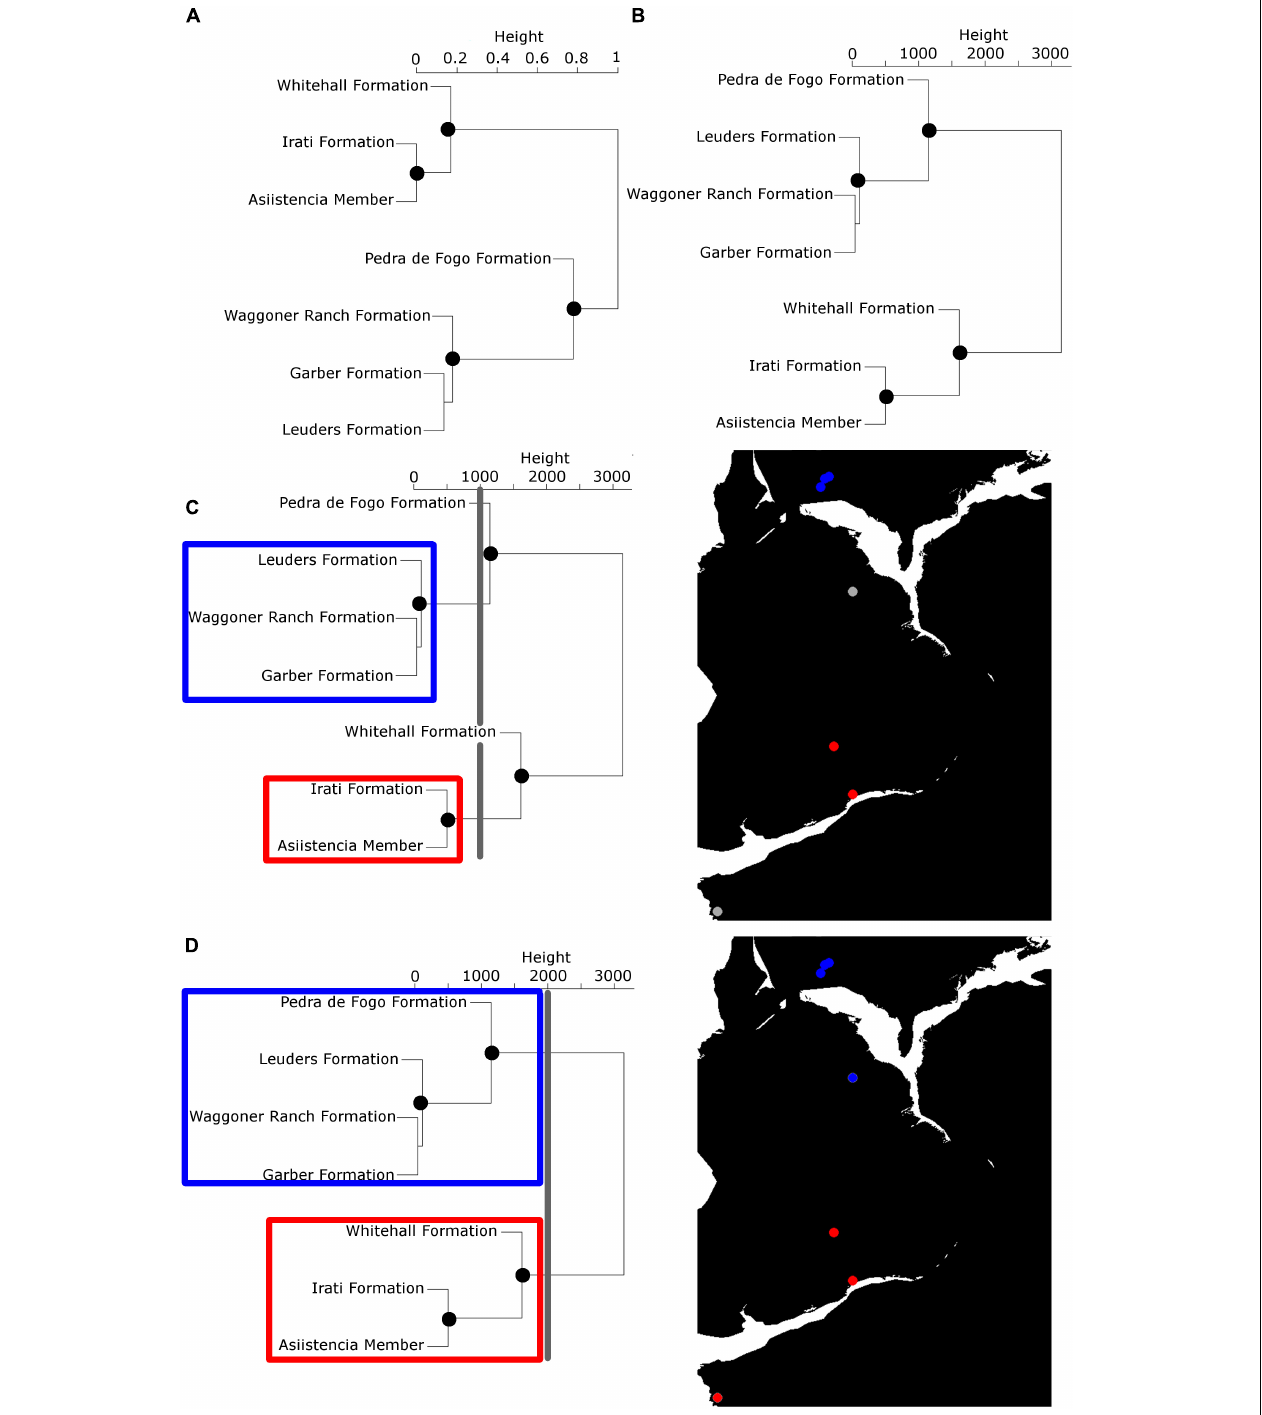
FIGURE 1 | An illustration of the method used to define bioregions, using the early Kungurian tetrapod record as an example time bin. (A) UPGMA (“average”) Cluster dendrogram of formations based on taxonomic (Forbes ∗ ) distances (Alroy, 2015); (B) Cluster dendrogram of formations based on Euclidean geographic distances. Nodes illustrated with black dots in A and B are shared between the two and represent continuous geographic areas of endemicity (bioregions). (C,D) An illustration of how the spatial scale at which the bioregions are defined is controlled. (C) A geographic cluster node height of 1000 km is used, so all formations within 1000 km of each other are united in their bioregions. Four bioregions are defined: those in blue (palaeoequatorial North America), those in red (palaeotemperature South America), and two individual formations colored in gray on the map. (D) A geographic cluster node height of 2000 km is used. Two bioregions are defined: Those in blue (palaeoequatorial formations) and those in red (Southern palaeotemperature formations). Maps from the R package paleomap.